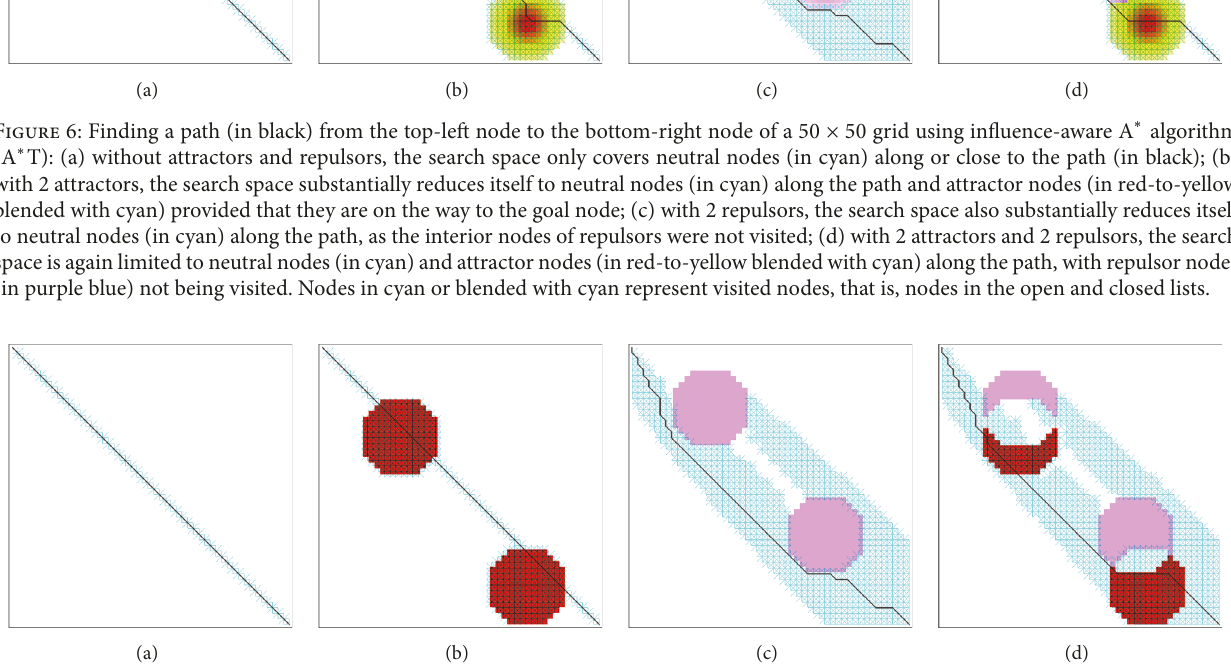
Figure 7: Finding a path (in black) from the top-left node to the bottom-right node of a 50 × 50 grid using the risk-adverse A ∗ algorithm (A ∗ RAP): (a) without attractors and repulsors, the search space only covers neutral nodes (in cyan) along or close to the path (in black); (b) with 2 attractors, the search space reduces itself to neutral nodes (in cyan) and influence-constant attractor nodes (in red blended with cyan) found on the way to the goal node; (c) with 2 repulsors, the search space covers neutral nodes (in cyan) found on the way to the goal node, but influence-constant repulsor nodes (in light lilac) repel the search; (d) with 2 attractors and 2 repulsors, the search space covers neutral nodes (in cyan) and influence-constant attractor nodes (in red blended with cyan) but not repulsor nodes (in light lilac). Nodes in cyan or blended with cyan represent visited nodes, that is, open and closed nodes.